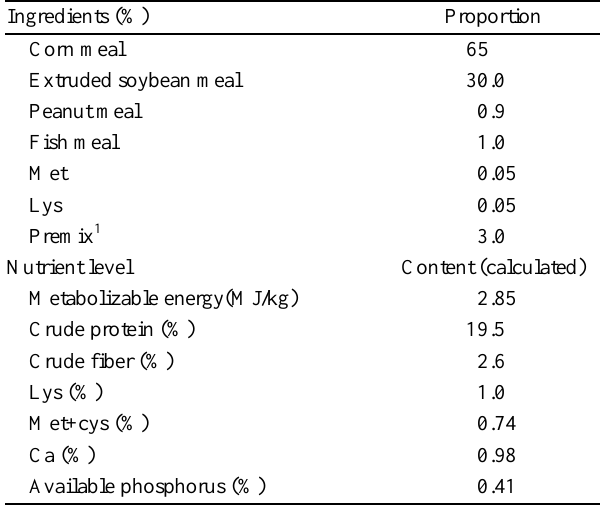
Table 1. Composition of corn-soybean basal diet Ingredients (%)